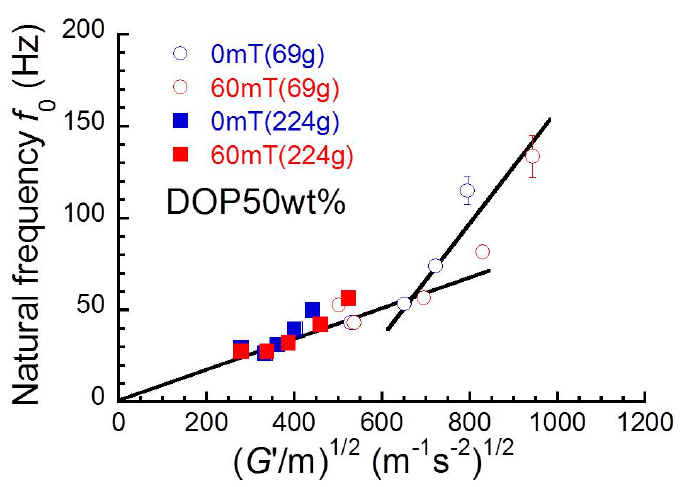
Figure 4. Relationship between natural frequency and ( G ’/ m ) 1/2 in Equation (3) for all magnetic elastomers under two different loads.